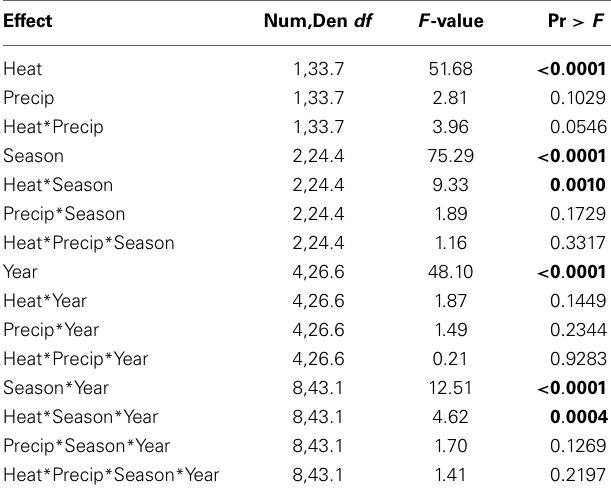
Table 2 | Statistical results of the effects of the climate treatments ( + heat and + precip), season, year, and their interactions on tall fescue relative abundance in a mixed species pasture.